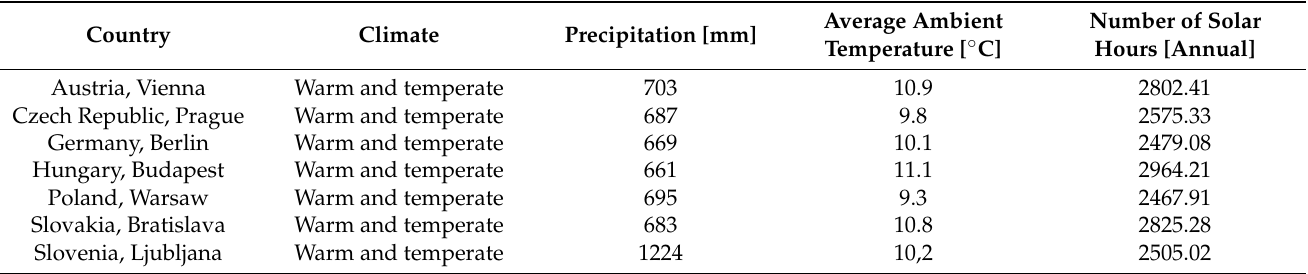
Table 1. Climate characteristics for the capital cities based on https://en.climate-data.org/europe (accessed on 10 September